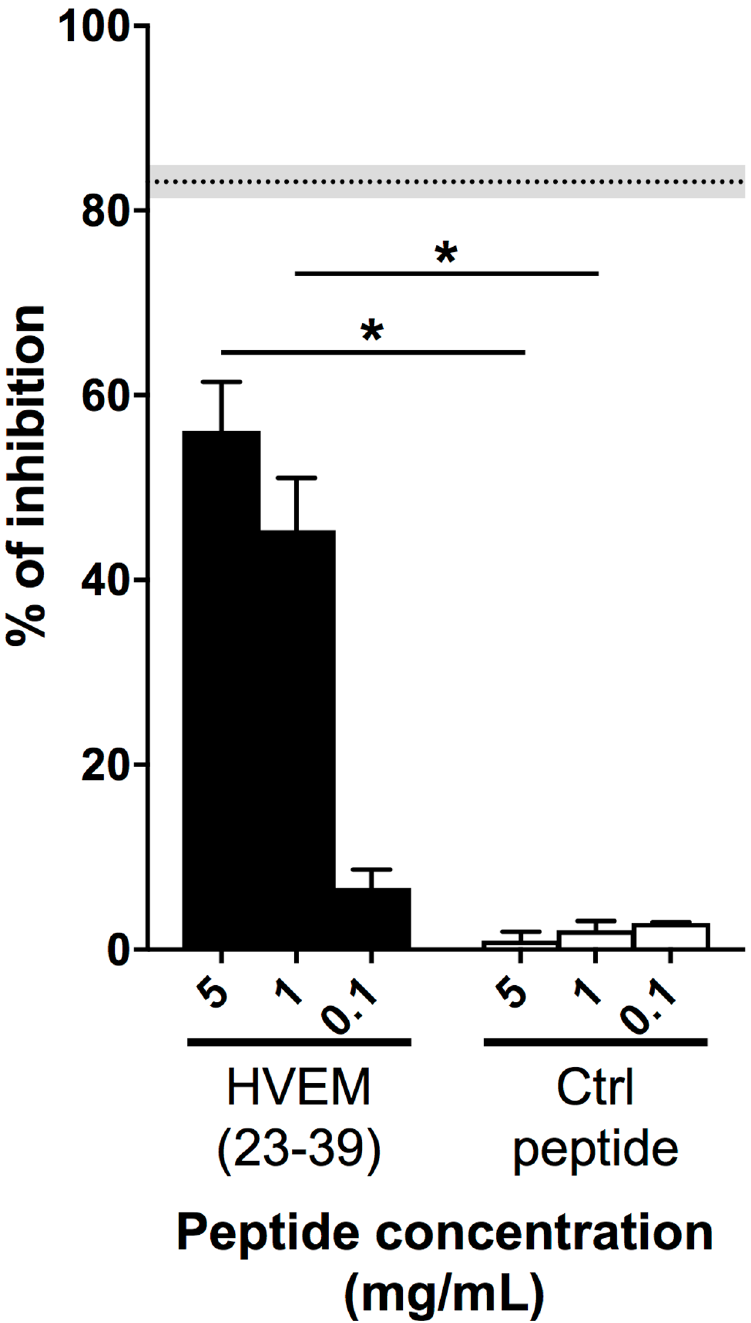
Fig 3. HVEM(23–39) peptide partially blocks the BTLA/HVEM binding. Inhibitionof the BTLA/HVEM interaction was assessed by ELISA (at least two experiments in triplicate). The graph shows percentages of inhibitionof the BTLA/HVEM ligation,relative to the negative control (PBS), in the presenceof different concentrations (5, 1 and 0.1 mg/mL) of HVEM(23–39) and corresponding scrambledpeptide(Ctrl peptide). The gray and dotted back lines correspond to the percentages of inhibition observed with an anti-BTLA blockingantibody(Mean +/-SEM). * : p < 0.05 followingnon-parametric One-way ANOVA and Dunn’spost-